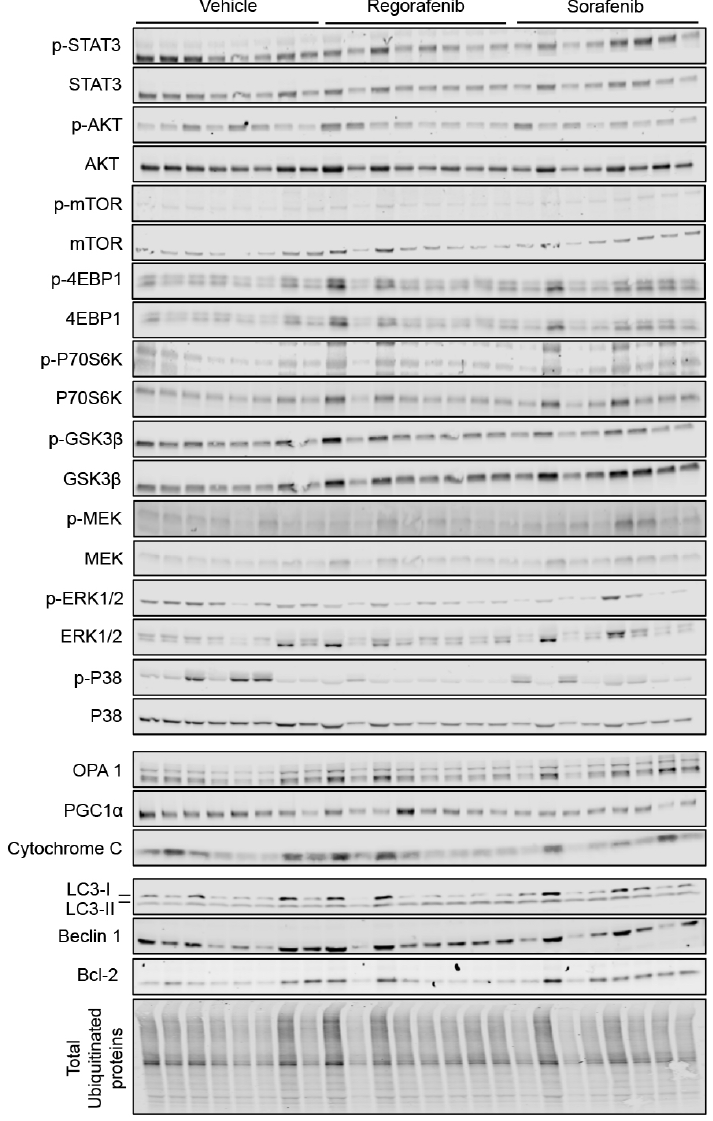
Figure 4. Cont Figure 4. Cont.